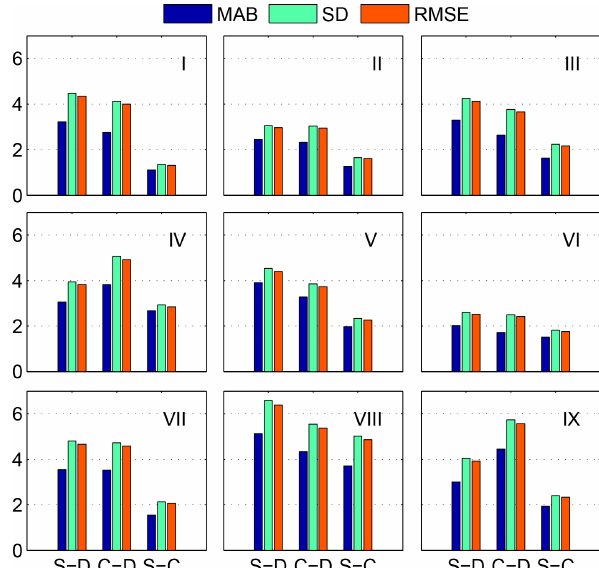
Figure 2. Statistical summary of annual anomaly R s from direct observed R s , SunDu-derived R s , and CERES EBAF R s estimates in different subregions. The statistics include the mean absolute bias (MAB), standard deviation (SD), and root-mean-square error (RMSE). We use MAB due to the cancelling out effect of posi- tive bias and negative bias. Nine subregions (I to IX) over China are shown in Fig. 1. S-D represents comparisons between SunDu- derived R s and directly observed R s . C-D represents comparisons between CERES EBAF R s and directly observed R s . S-C repre- sents comparisons between SunDu-derived R s and CERES EBAF R s . The unit of the y axis is Wm − 2 .